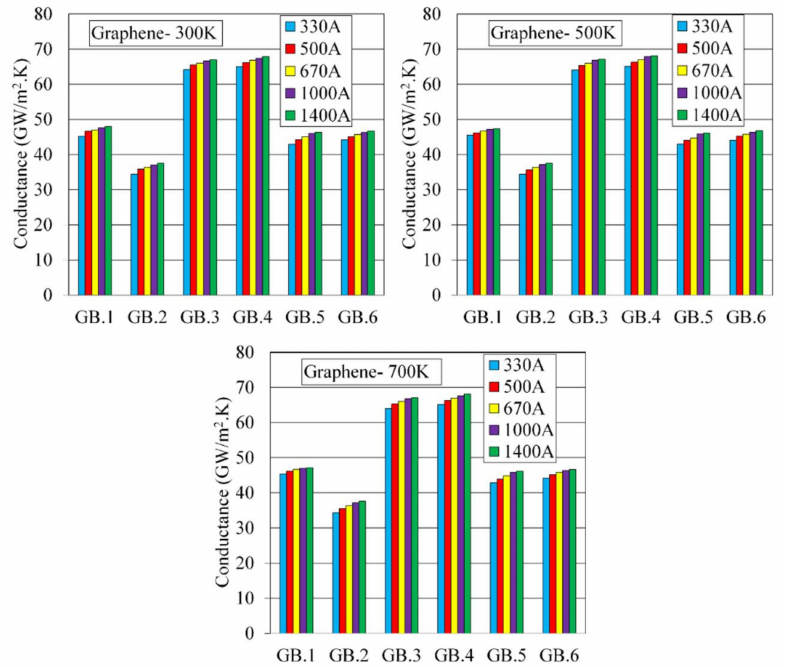
Figure 10. Predicted the term of thermal conductance of Graphene material for six grain boundaries, sheet lengths (330 A, 500 A, 670 A, 1000 A and 1400 A) and three temperatures (300 K, 500 K and 700 K).